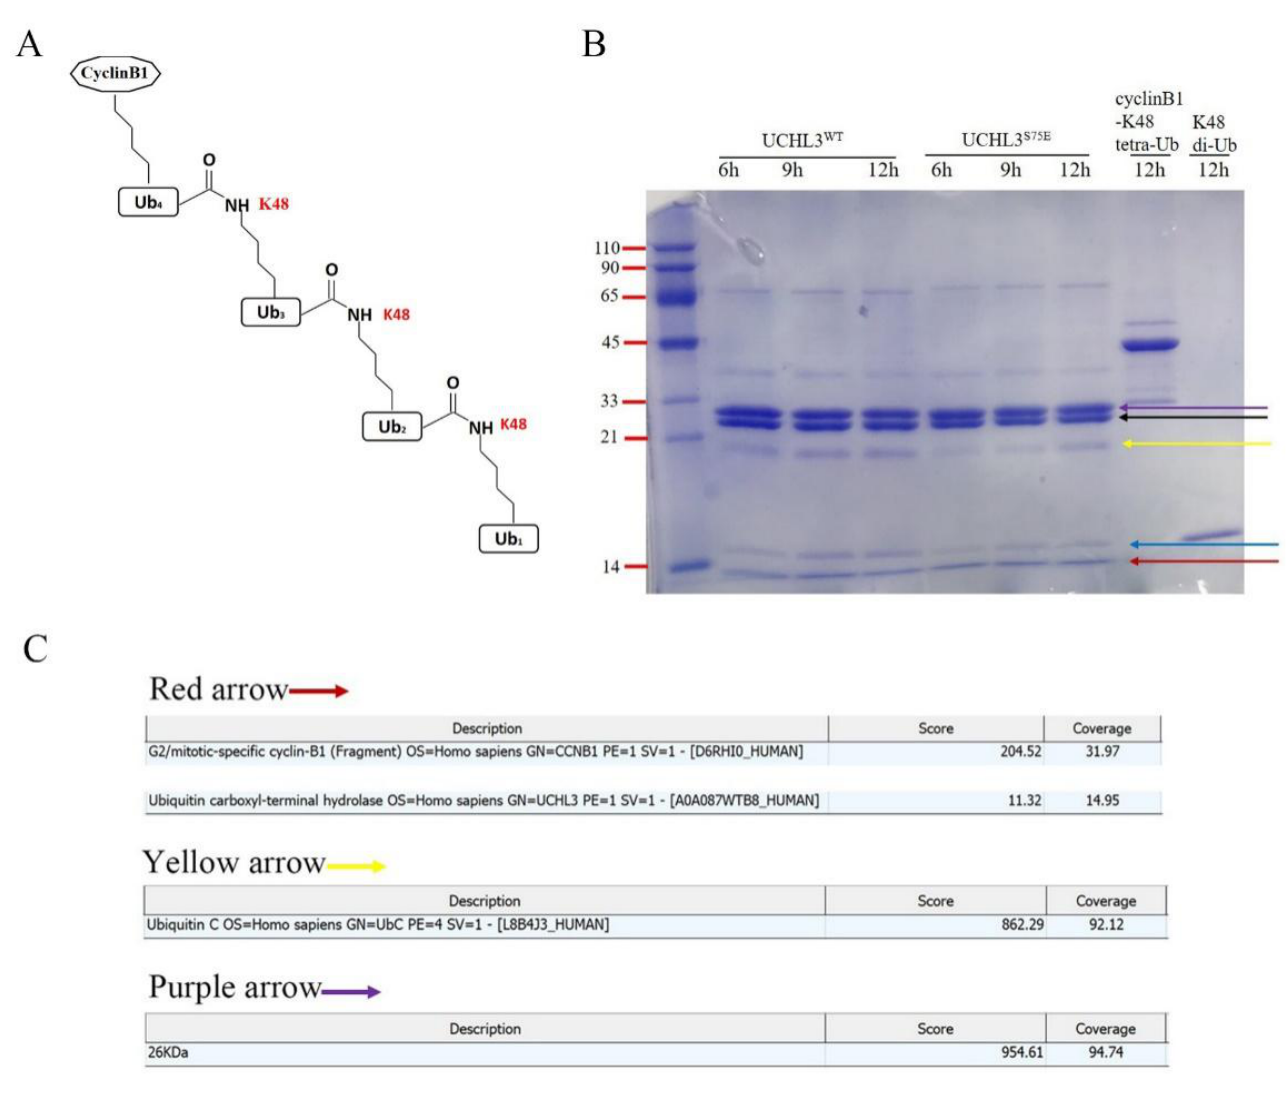
Figure 6. Hydrolysis activity of UCHL3 toward cyclinB1-K48 tetra-Ub. ( A ) Pattern diagram of the substrate of cyclinB1-K48 tetra-Ub. ( B ) UCHL3 S75E or UCHL3 WT was incubated with the substrate and the reaction products were fractionated by SDS/PAGE and visualized by Coomassie Blue staining; different products are indicated by arrows of different colors. The black arrow indicates UCHL3 WT or UCHL3 S75E . ( C ) Mass spectrometry results of the hydrolysis bands correspond to the arrows in different colors.